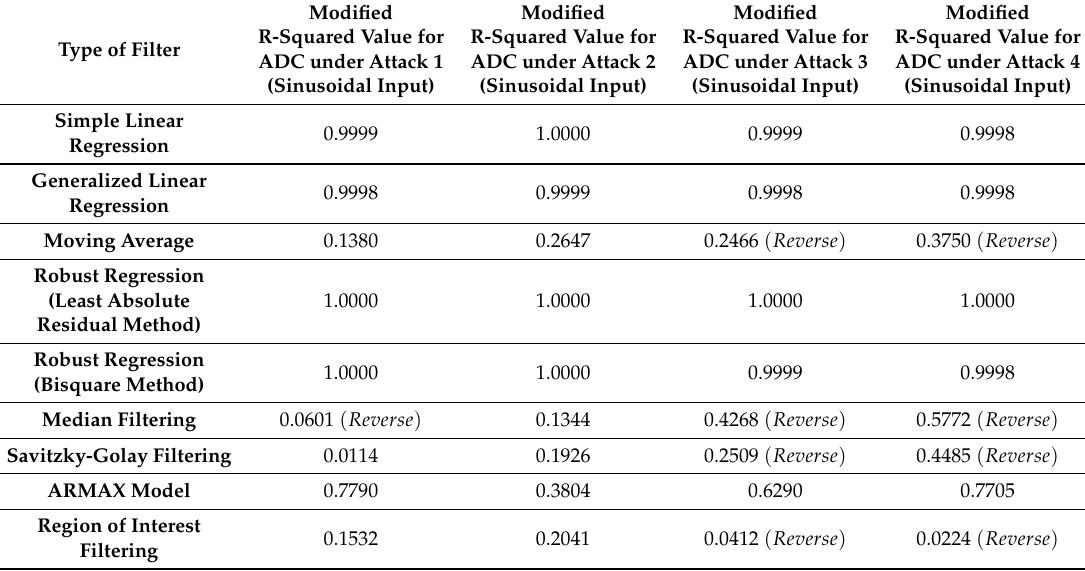
Table 5. Defense Analysis Under Process Variations (2): The performance analysis of filters based on their corresponding modified R-squared values when a sinusoidal signal is applied to the modulator and the threshold voltage of the transistors is 20% lower than its typical